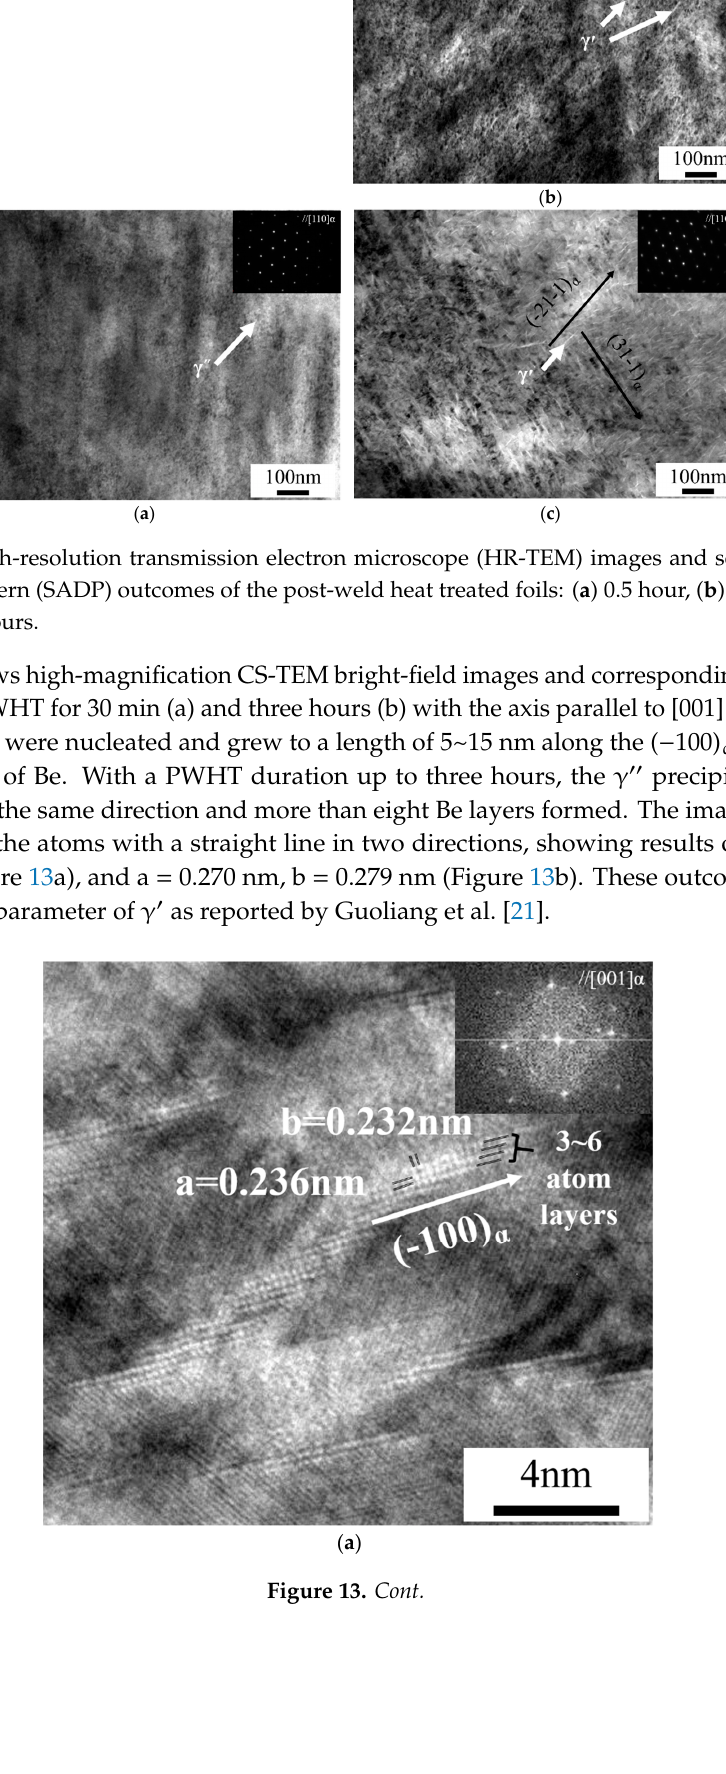
Figure 11. SEM images of discontinuous precipitation (DP) cells formed at the grain boundaries of the stir zone subject to PWHT: ( a ) 0.5 hour, ( b ) three hours and ( c ) eight hours.